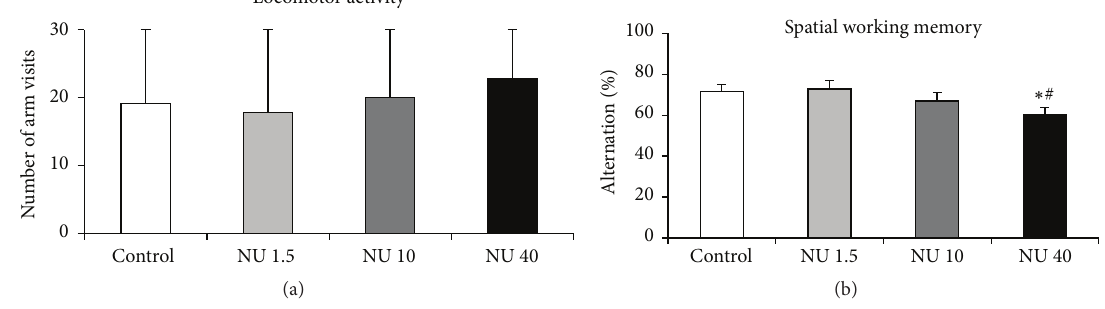
Figure 3: Locomotor activity and spatial working memory of male rats exposed to 1.5, 10, or 40 mg ⋅ L −1 NU from birth for 9 months. (a) shows the number of arm entries in the Y-maze and reflects locomotor activity. (b) shows the alternation between arms, expressed as a percentage (%), in the Y-maze and reflects spatial working memory. The data are presented as mean ± SEM; 𝑛 = 12 for each group; NU: natural uranium; ∗ 𝑝 < 0.05 , significant difference from control; # 𝑝 < 0.05 , significant difference from 1.5mg ⋅ L −1 NU.